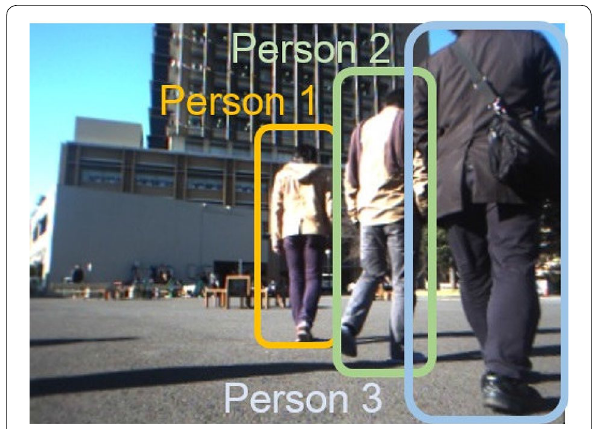
Fig. 3 Example of a color image